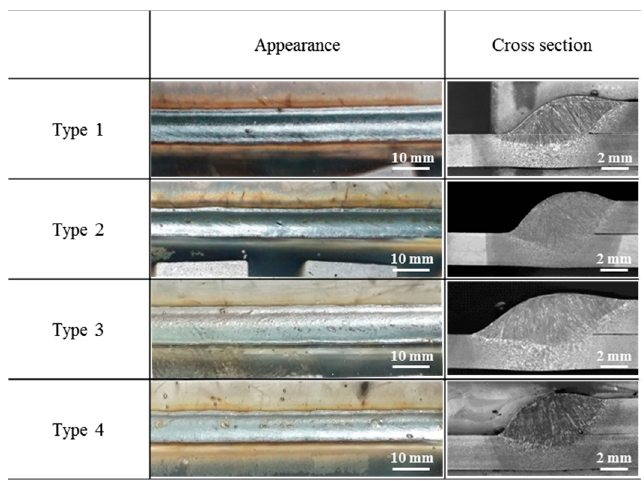
Figure 5. Weld bead shape and cross section of the weld according to weld type.